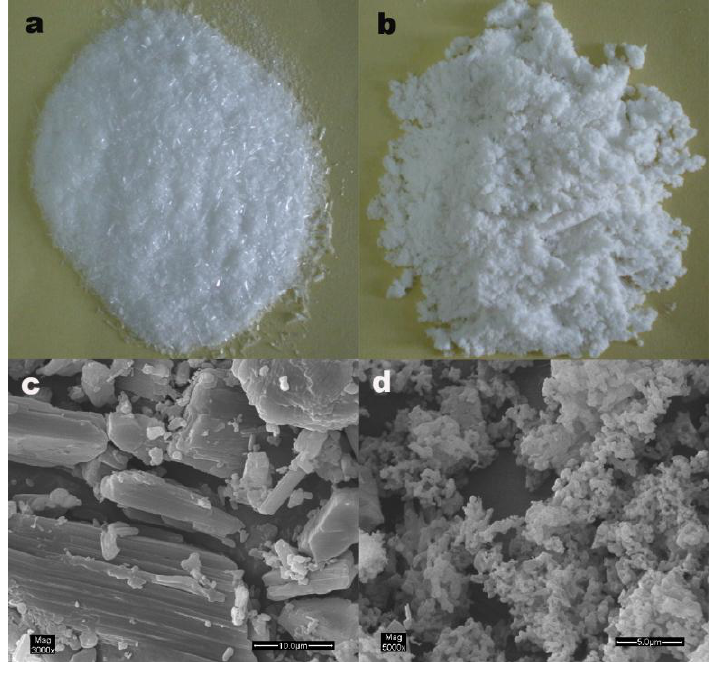
Figure 3. The particle morphology of unprocessed and processed artemisinin.